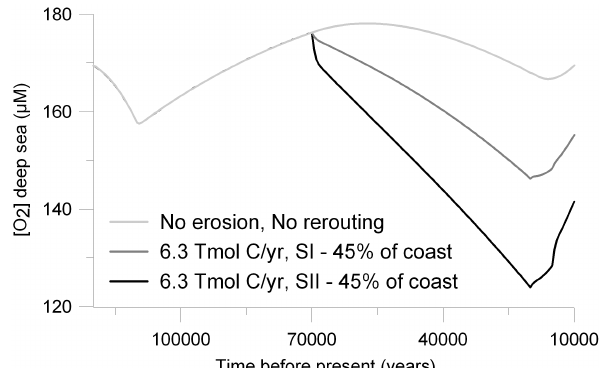
Fig. 3. The evolution of deep-sea oxygen concentrations during a glacial-interglacial cycle in the model. The light gray line repre- sents a glacial interglacial climate change scenario as detailed in Tsandev et al. (2008) without modifications. It corresponds to the oxygen profile of Fig. 6 in ( Tsandev et al., 2008). The dark gray line corresponds to the same glacial scenario with an additional flux of material eroded from exposed shelves (Table 1) and the forma- tion of submarine canyons for major rivers (for 45% of the coast ocean) according to routing SI. The black line corresponds to the glacial scenario plus a flux of material eroded from exposed shelves and the formation of submarine canyons for major rivers (45% of coastal ocean) according to routing scenario SII. All runs assume a moderate redox dependence in P burial (Slomp and Van Cappellen,